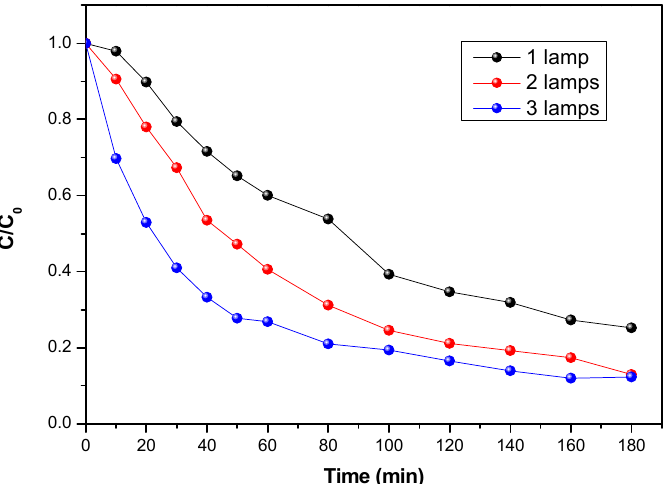
Figure 6. Evolution of the concentration of flumequine during its photocatalytic degradation for an initial concentration of 5 mg/L, three light intensities, and a flow rate of 29 L/h.